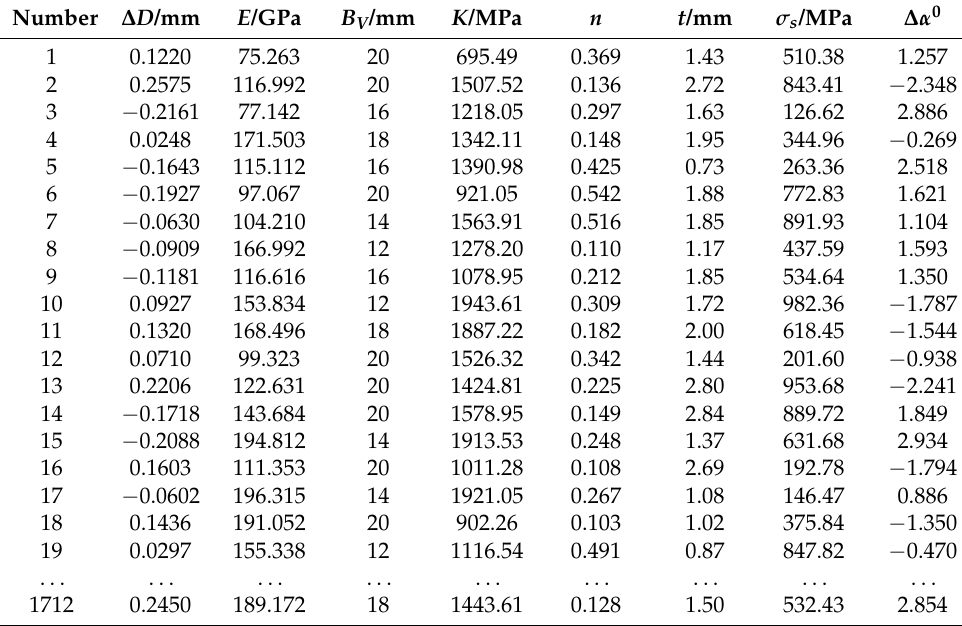
Table 7. Modeling samples for the correction model.